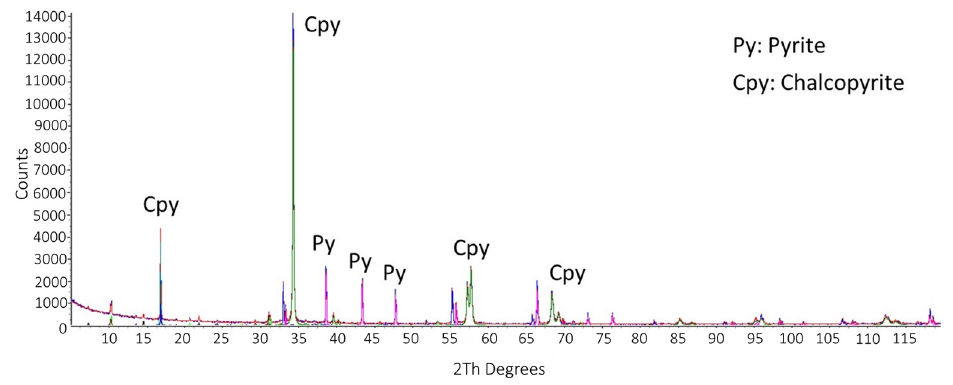
Figure 4. X-ray diffraction pattern of the chalcopyrite concentrate. A typical analysis of the seawater is presented in Table 2, which was obtained using different analytical techniques (ICP-AES, atomic absorption spectrometry-AAS, Volumetric, and Gravimetric